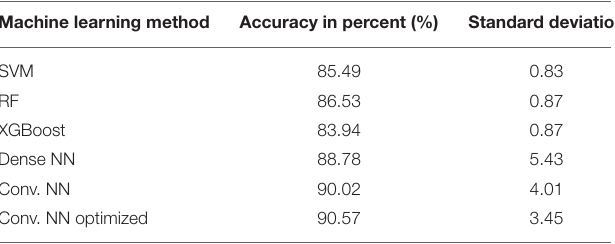
TABLE 1 | Achieved accuracy per method for 2018 follow-up dataset: table showing the executed machine learning methods and the achieved accuracy in percent as well as standard deviation during cross